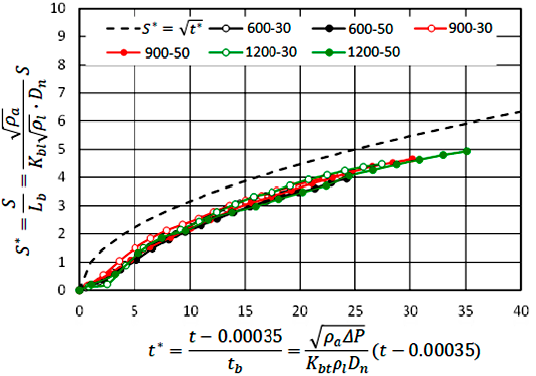
Figure 23. Normalized spray penetration length at back pressure of 30 and 50 bar (nozzle diameter: 0.30 mm, injection pressure: 600, 900, and 1200 bar by common rail).